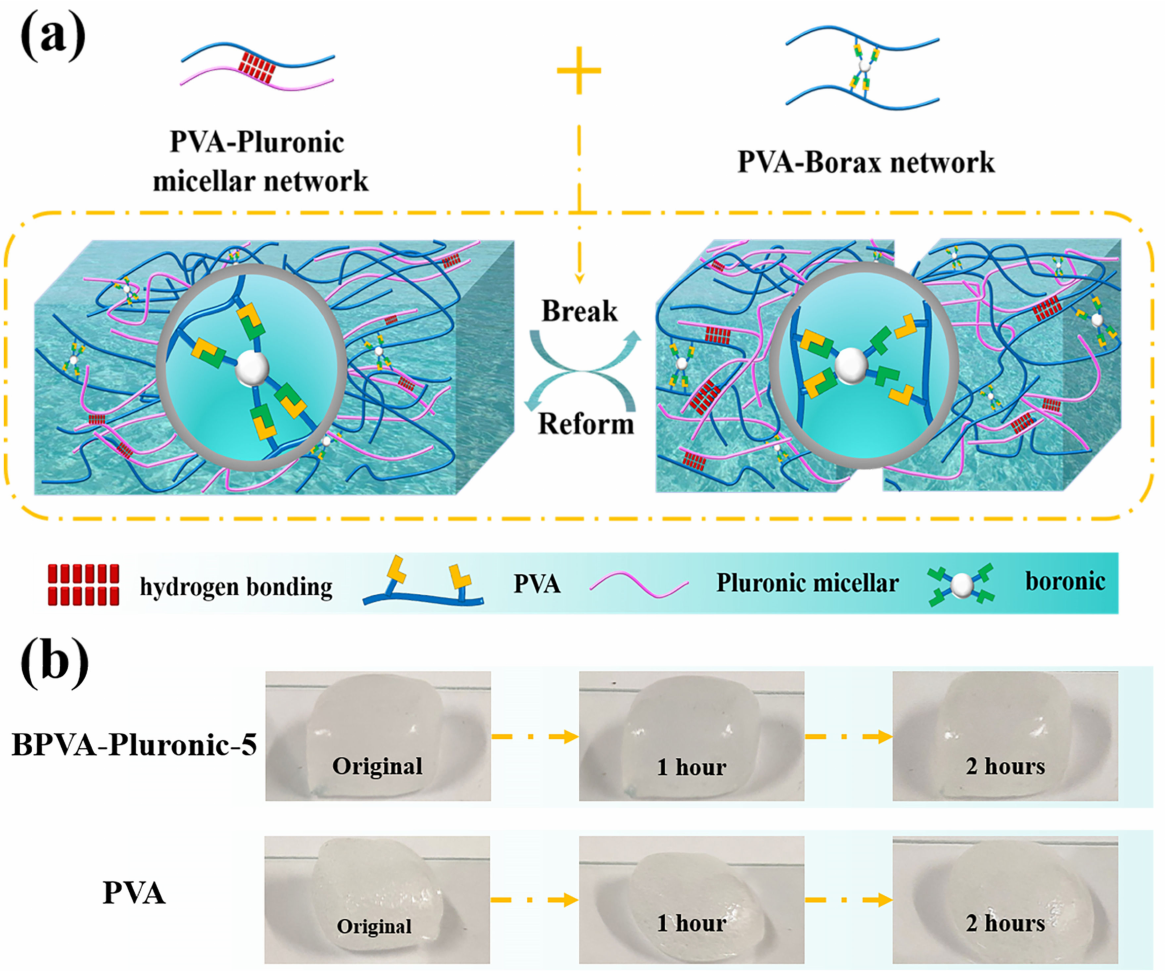
Figure 1. ( a ) Schematic illustration of the formation and structure of BPVA-Pluronic hydrogel. ( b ) Shape stability of BPVA-Pluronic-5 hydrogel and PVA